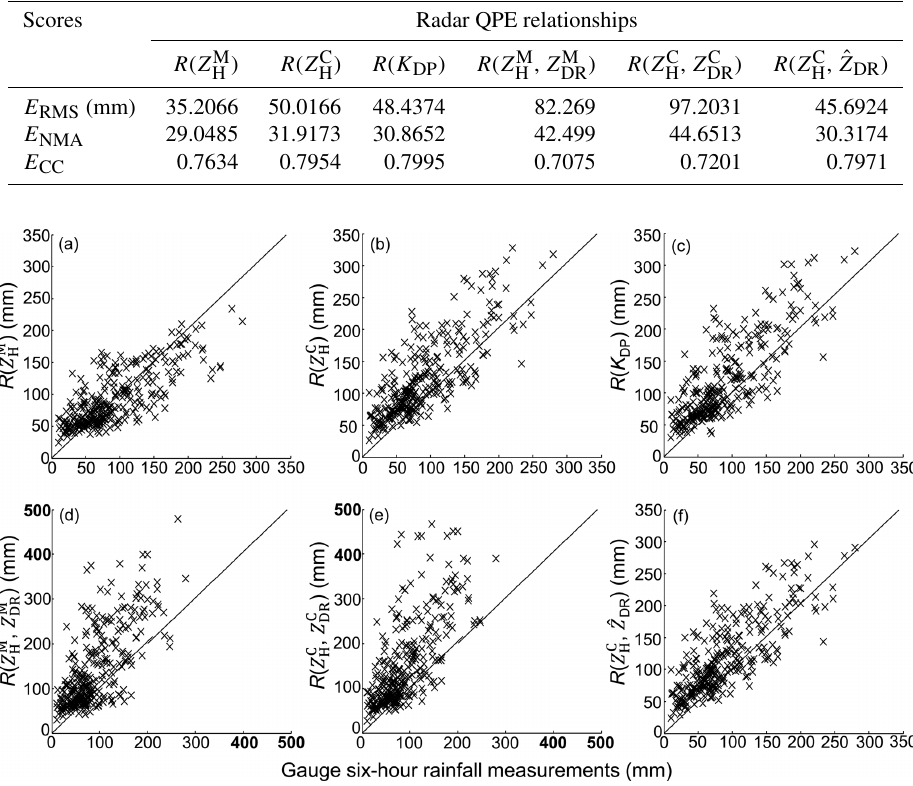
), (b) R ( Z C ), (c) R ( K DP ), (d) R ( Z M H H